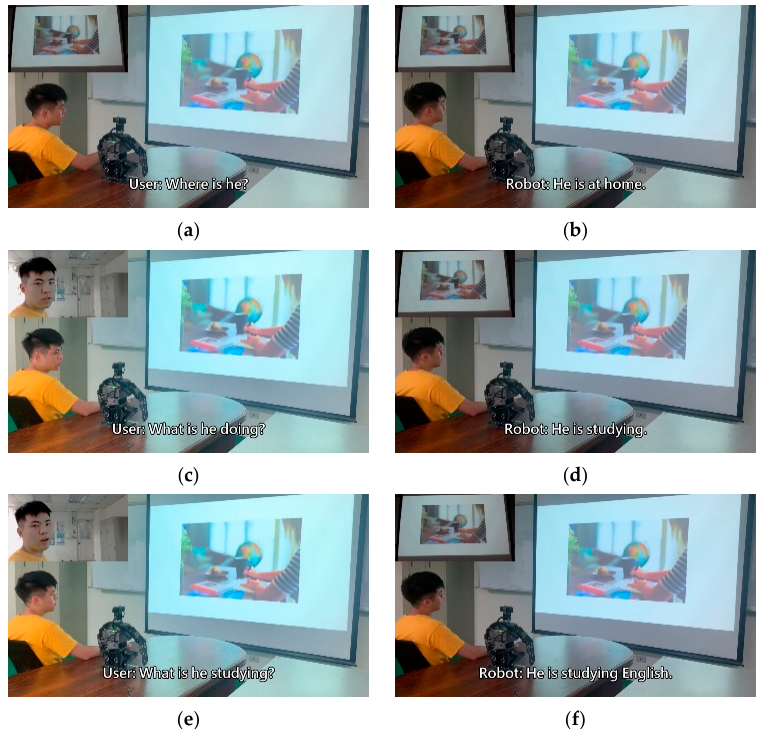
Figure 15. Experimental result in scenario C.